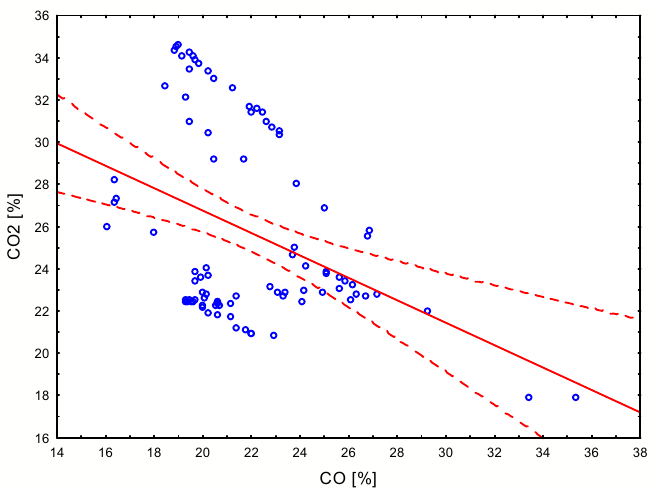
Figure 9. Correlation between the percentage of CO 2 and CO.